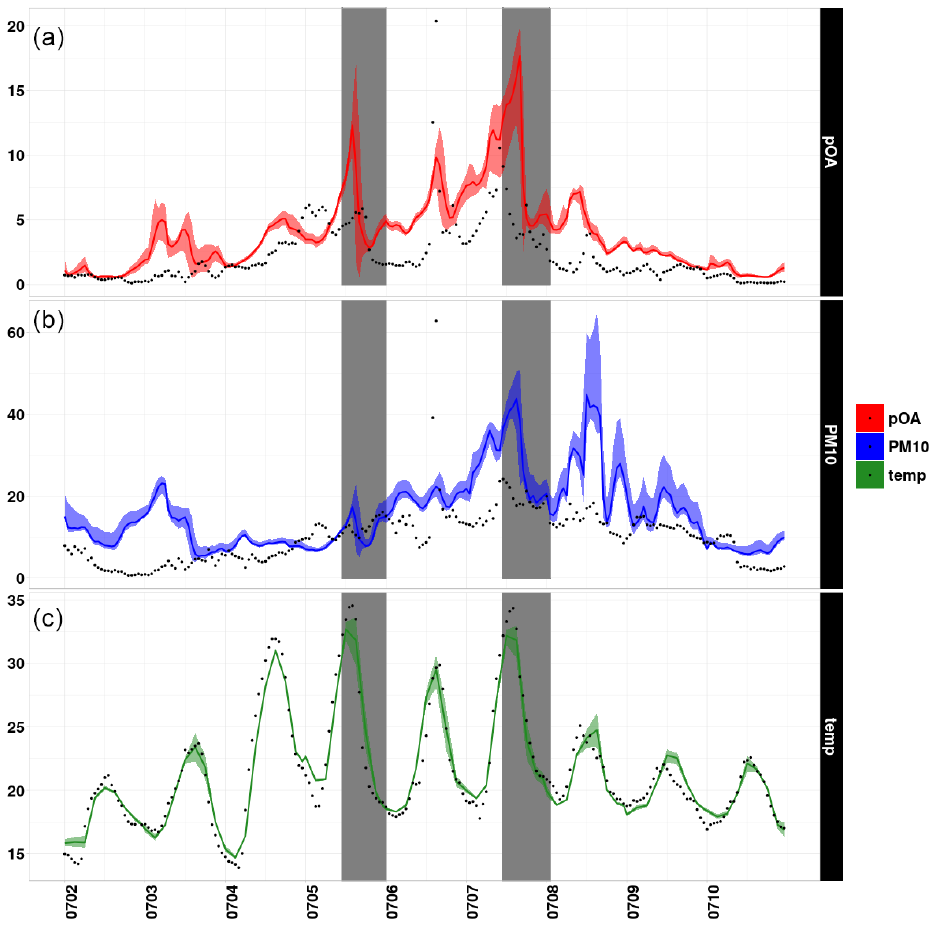
Figure 15. Time series for BSOA (µgm − 3 ), PM 10 (µgm − 3 ), and temperature ( k ) for the two sea breeze episodes compared to measurements. The episodes are highlighted in each panel. The confidence interval corresponds to the concentrations seen in a 11km × 11km square around the measurement site. The gray zones correspond to times of the passage of the sea breeze